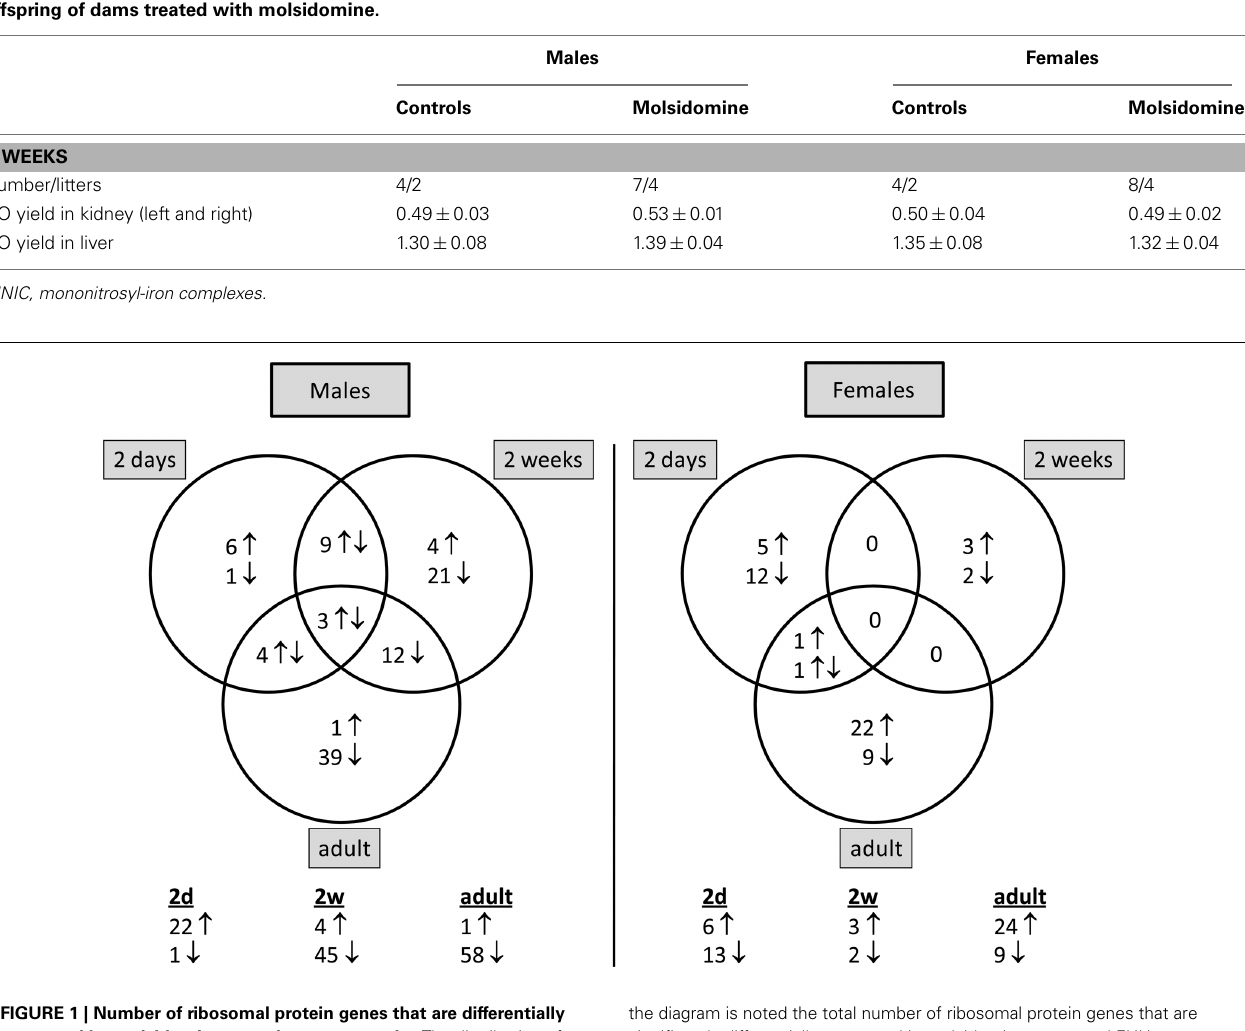
FIGURE 1 | Number of ribosomal protein genes that are differentially expressed by molsidomine at each age per gender. The distribution of these genes between ages per gender is shown in theVenn diagram. Below